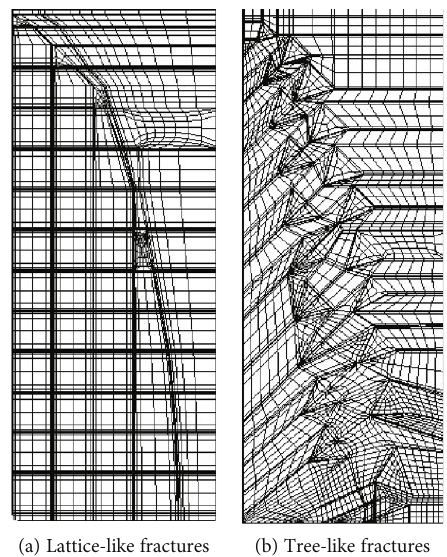
Figure 3: Local area grids of lattice-like and tree-like fracture